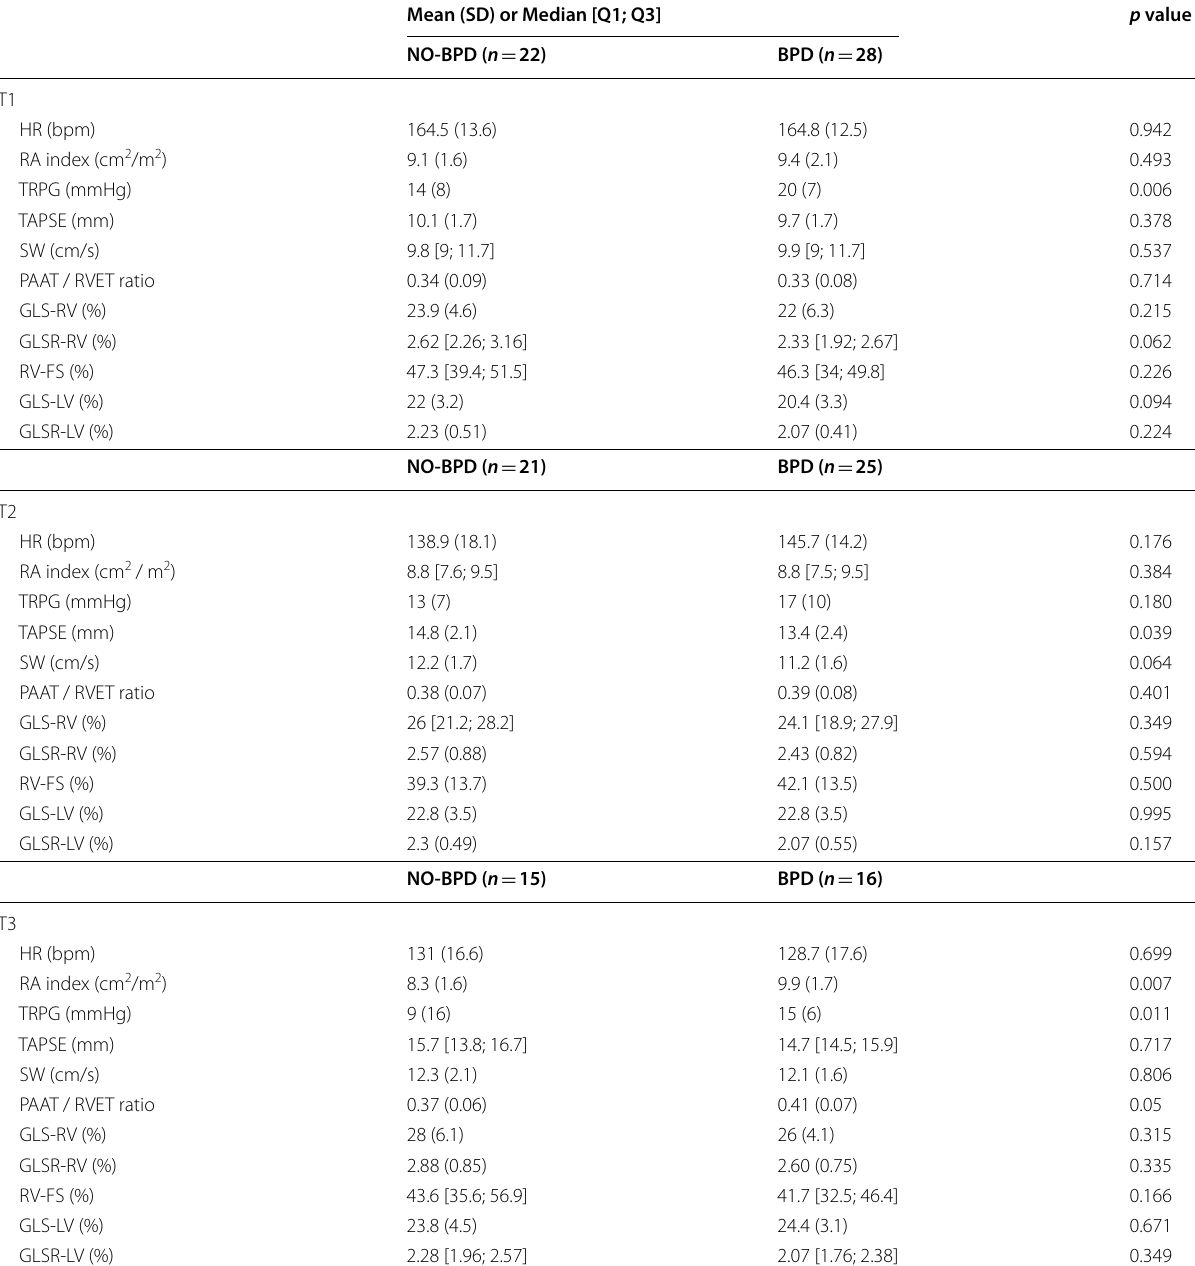
Table 2 Echocardiographic measurements at the three